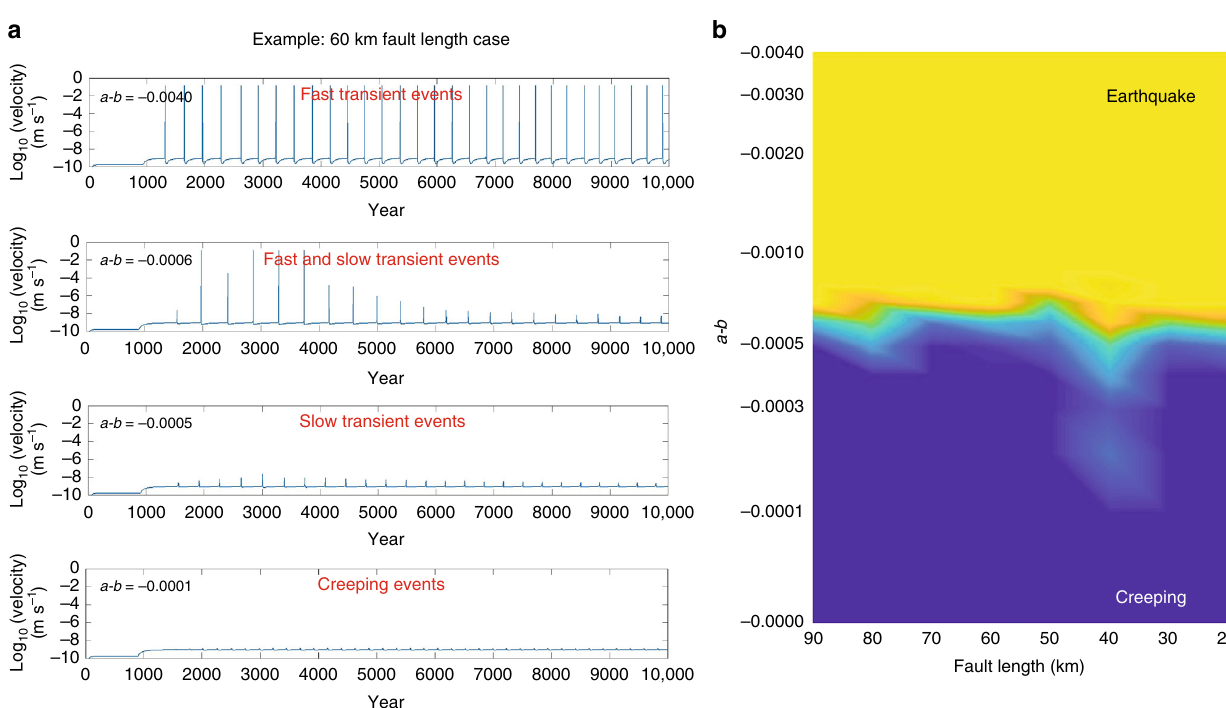
Fig. 3 Emergence of fast slips and slow transients. a Slip mode transition on models with 60 km fault length and different a − b values. b Slip behavior for different fault lengths and a − b values. The scale bar shows the ratio between number of earthquakes and slow transient events. Yellow: the model only generates earthquakes. Blue: the model only generates creeping events